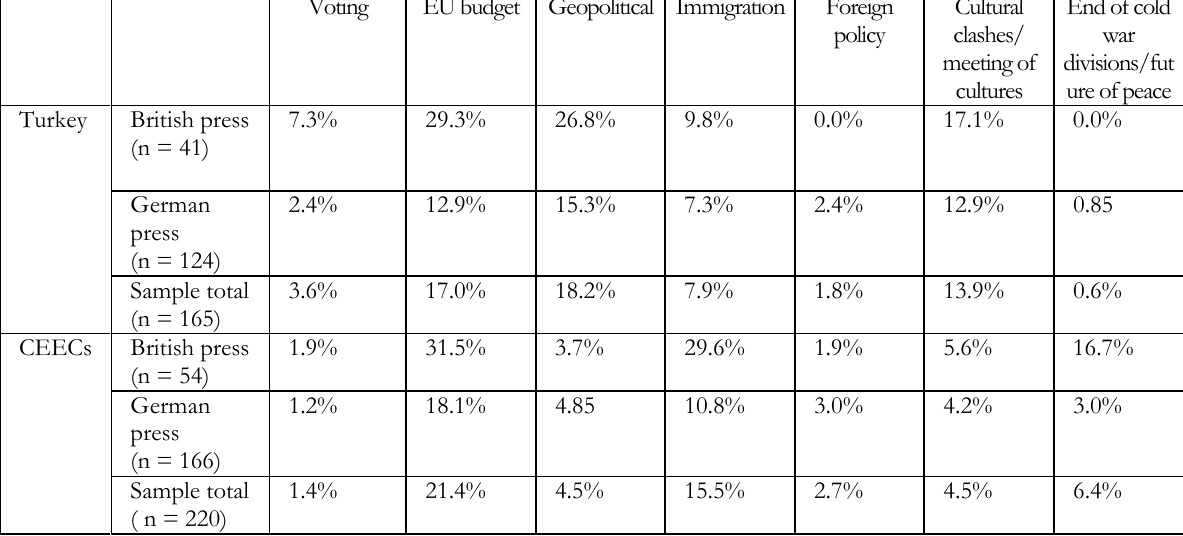
Table 2: Consequences of enlargement associated with Turkey and CEECs Voting EU budget Geopolitical Immigration Foreign